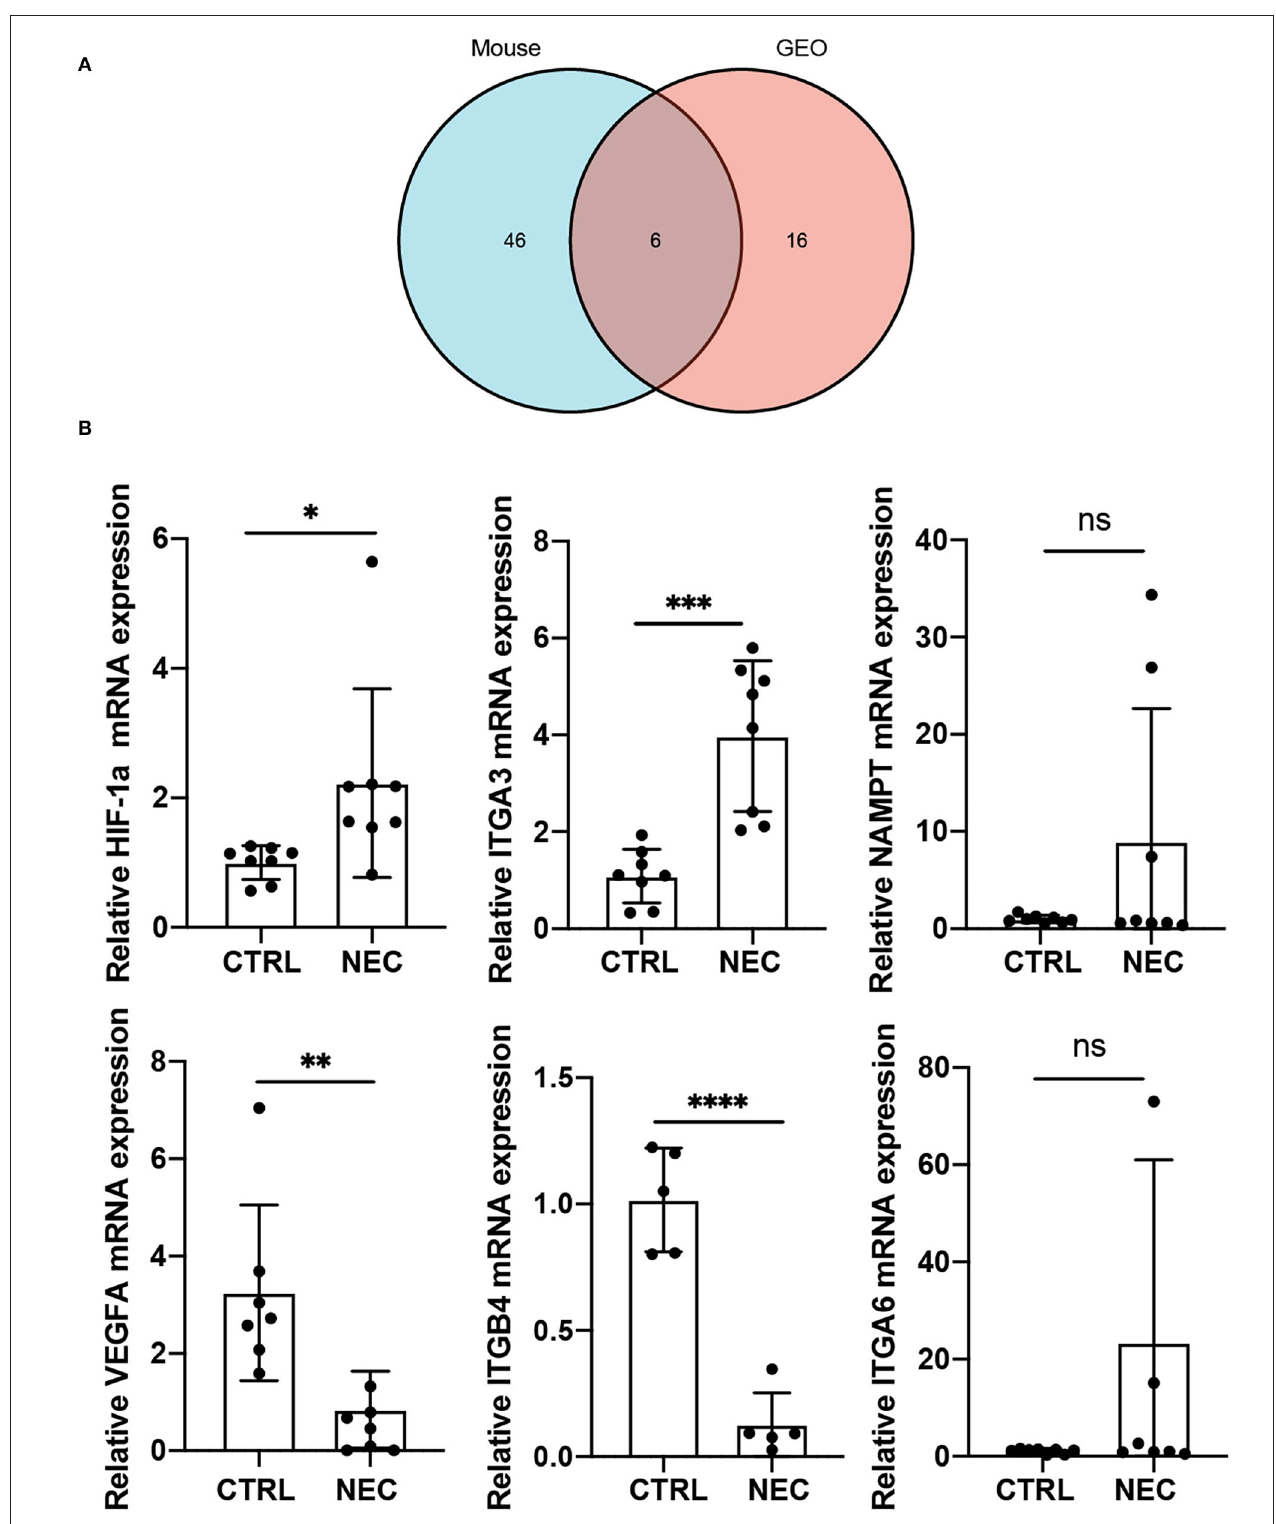
FIGURE 4 | Validation of co-expressed autophagy-4elated genes in a mouse model of NEC. (A) Venn image of co-expressed autophagy-related genes in a mouse model of NEC and human NEC from dataset GSE46619. (B) The mRNA expression level of co-expressed autophagy-related genes in a mouse model of NEC. ns, no significance; p > 0.05; * p < 0.05; ** p < 0.01; *** p < 0.001; and **** p < 0.0001.